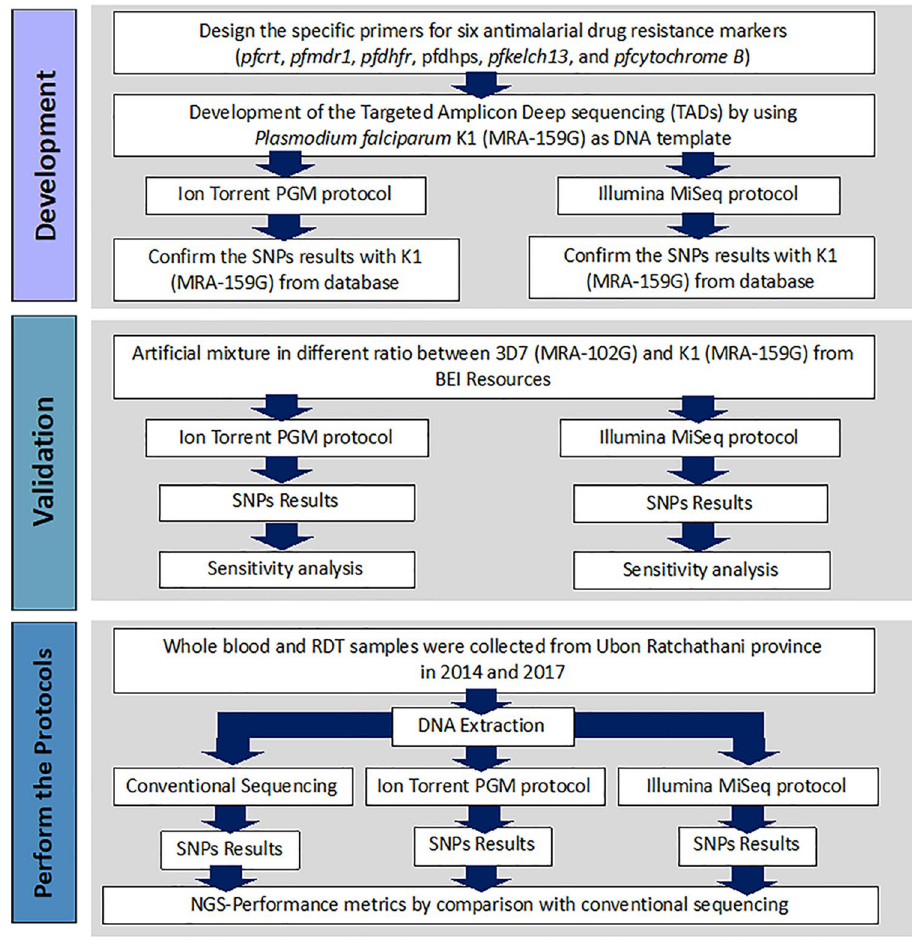
Figure 1. The workflow of the development of Targeted Amplicon Deep sequencing (TADs) for six drug resistance genes of P. falciparum by using Ion Torrent PGM and Illumina MiSeq protocol. There are three